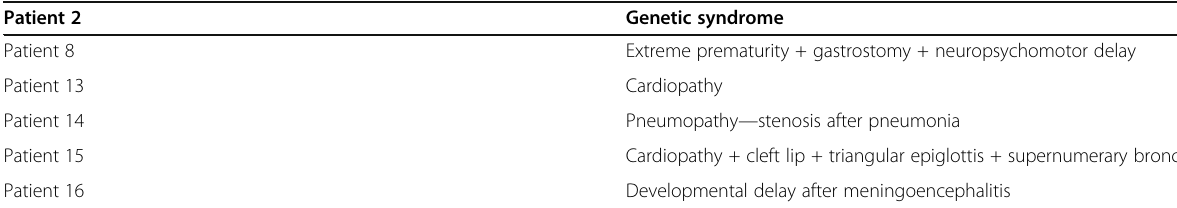
Table 2 Associated comorbidities Patient 2 Genetic